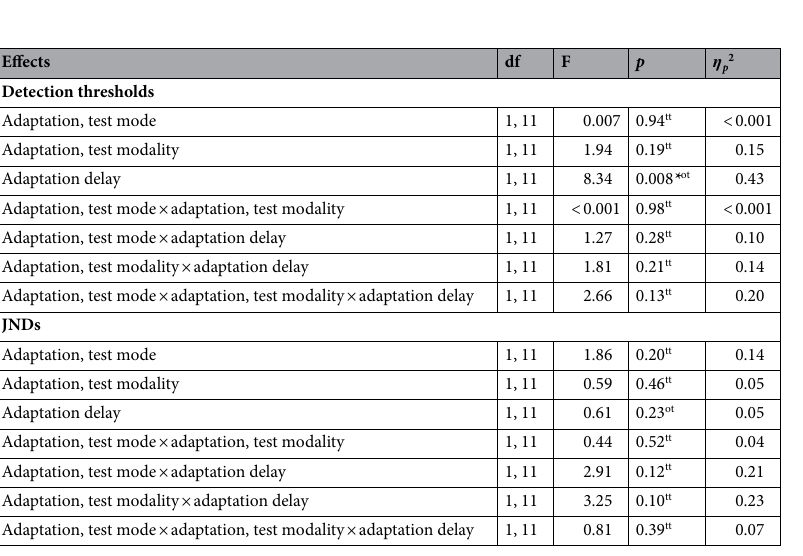
Table 6. Repeated-measures ANOVA results on detection thresholds and JNDs assessing transfer effects for adapt-V conditions. Bold asterisks indicate significant effects. ‘ ot ’ indicate one-sided test values whereas ‘ tt ’ indicate two-sided test values. df, degrees of freedom; F, F value, p , p value; ƞ p 2 partial